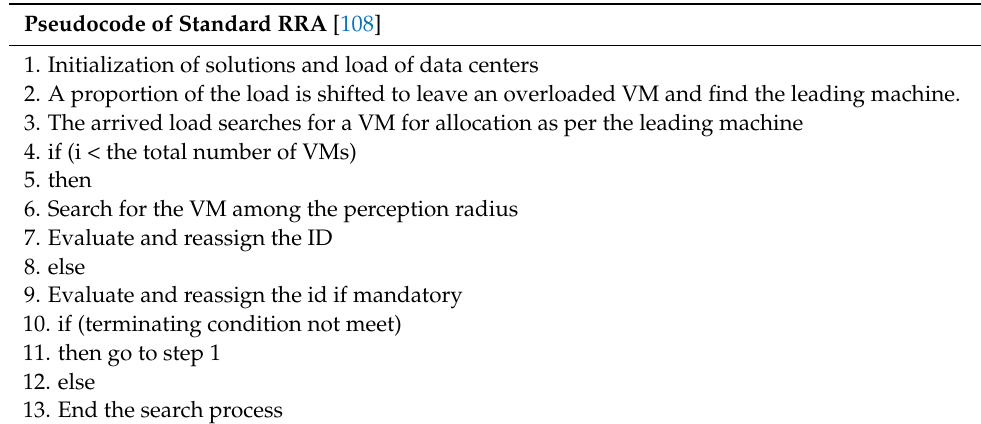
Figure 14. Social roosting behavior of raven roosting load balancing technique [91]. The steps involved are presented in the algorithm.